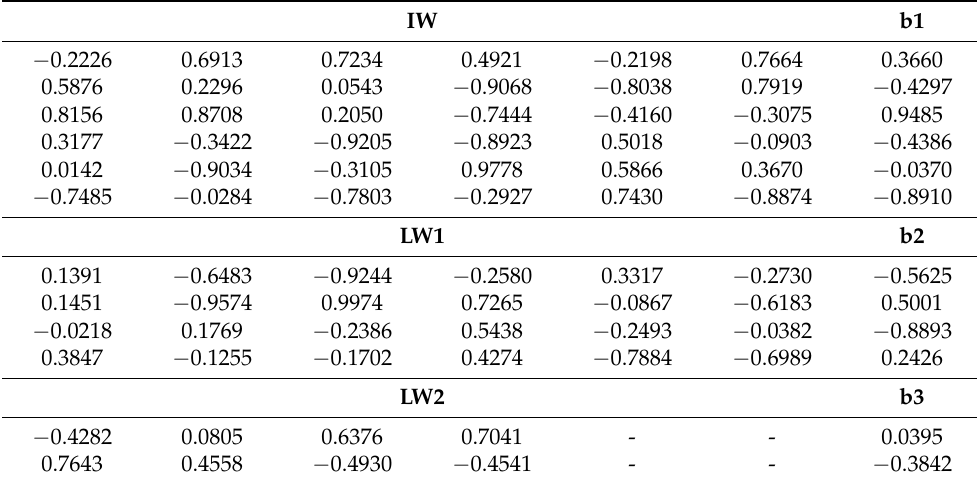
Table 7. Final weights and bias values of the optimum FA-ANN model 6-6-4-2. IW b1 −